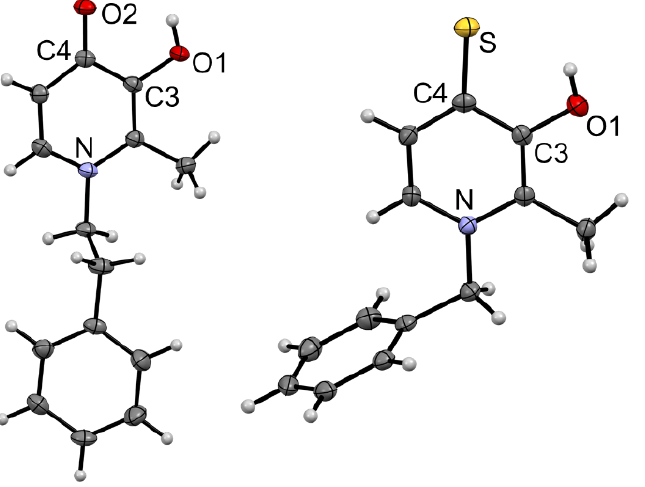
Figure 2. Molecular structures of 1b · MeOH and 1d drawn at 50% probability level. Solvent molecules have been omitted for clarity.